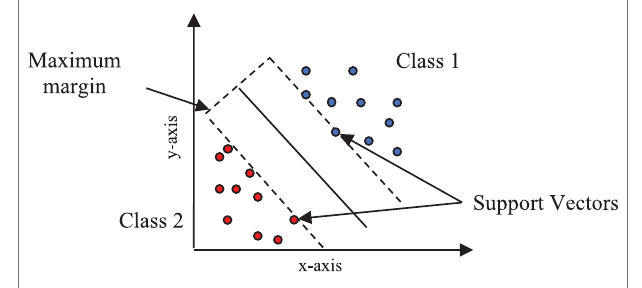
FIGURE 4 | Binary support vector